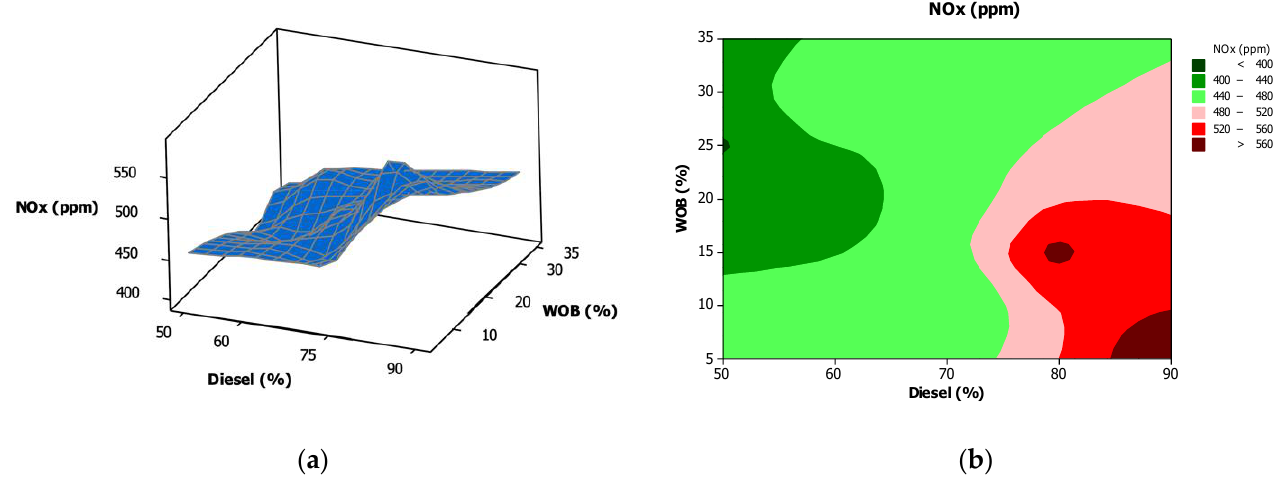
Figure 7. ( a ) Surface plot; ( b ) Contour plot of NO x emission with input variables.